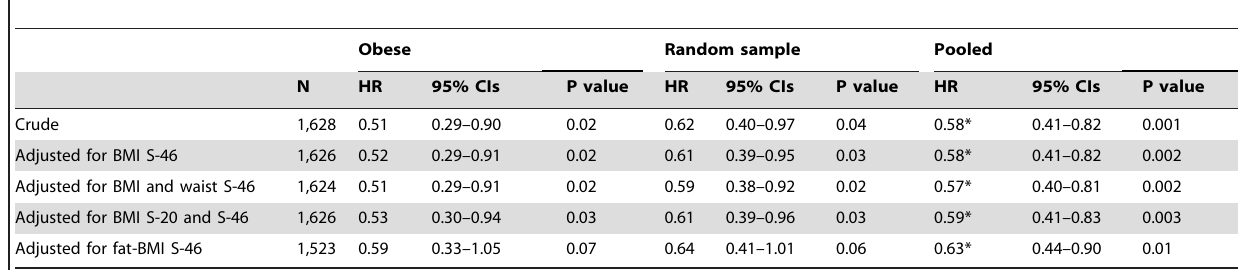
Table 3. FTO rs9939609 (genotype TT vs. TA and AA) and all-cause mortality in 1,628 Danish men